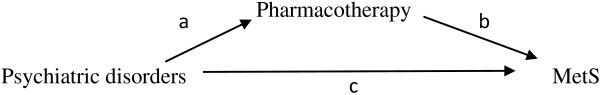
The model of mediation analysis. Note: The results of paths b and c are shown in the regression models I and II of Table 
4, respectively. In path a, the relationship between the use of antipsychotics and/or mood stabilizers and bipolar I disorder was significant, but it was not possible to calculate the odds ratio because all patients with bipolar I disorder were treated with antipsychotics and/or mood stabilizers.